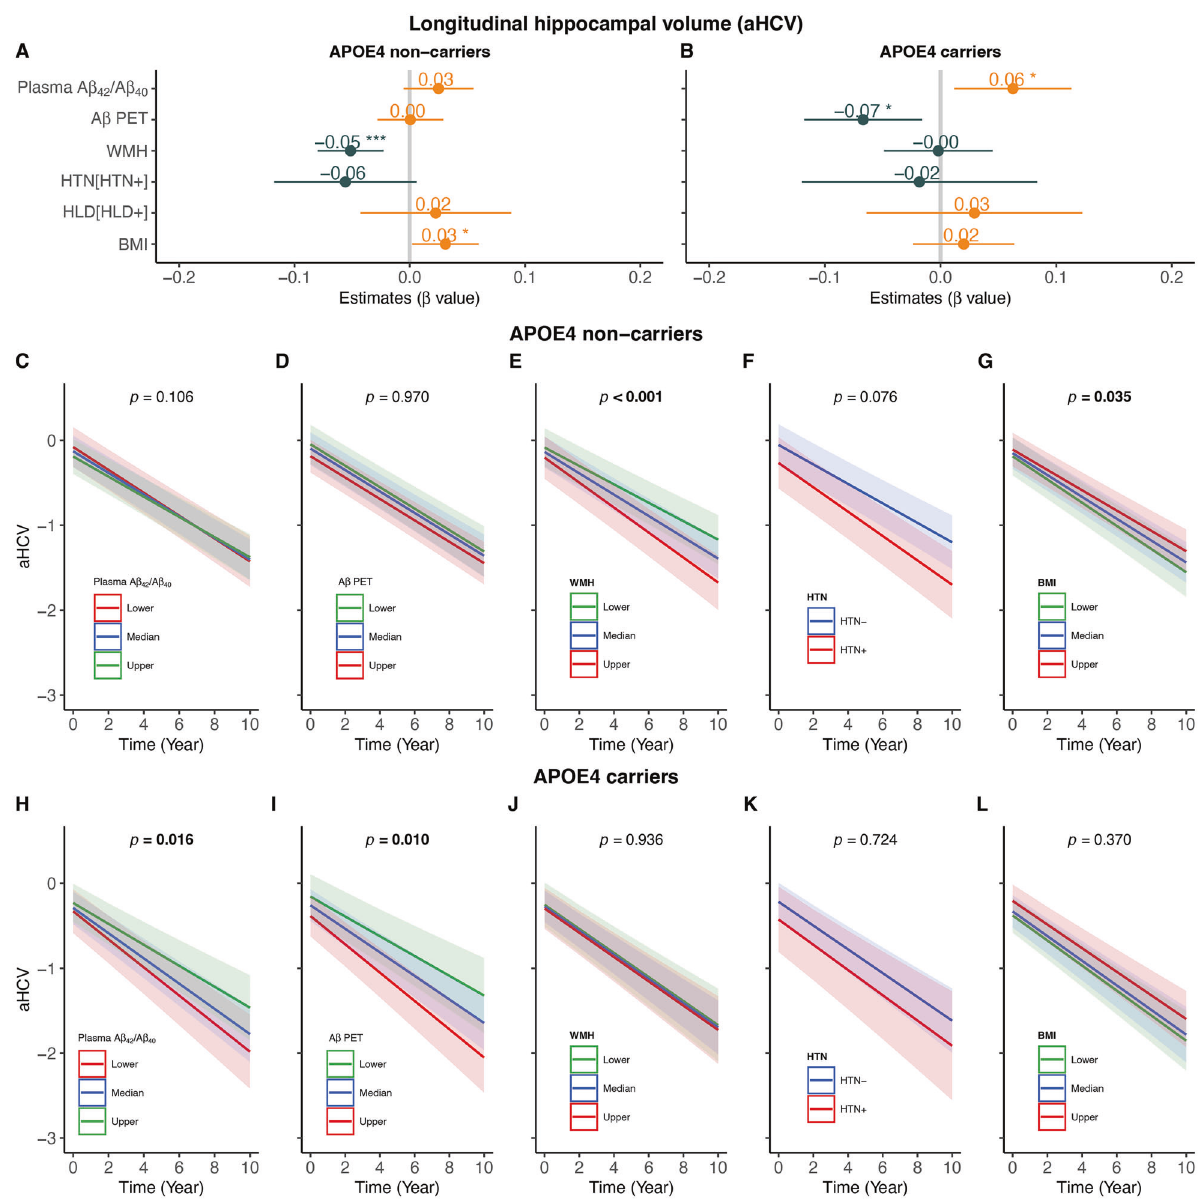
Fig. 3 Predictors of longitudinal hippocampal atrophy. Associations of longitudinal adjusted hippocampal volume (aHCV) with baseline plasma A β 42 /A β 40 , A β PET, WMH, hypertension (HTN), hyperlipidemia (HLD) and body mass index (BMI) in ( A ) APOE- ε 4 non-carriers and ( B ) APOE- ε 4 non-carriers. Prediction of longitudinal aHCV changes over time by baseline plasma A β 42 /A β 40 , A β PET, WMH, HTN and BMI in APOE- ε 4 non-carriers ( C – G ) and APOE- ε 4 carriers ( H – L ). Notes: APOE- ε 4 non-carriers (HTN − : n = 60, HTN + : n = 43), APOE- ε 4 carriers (HTN − : n = 44, HTN + : n = 18); lower, median and upper represent the value that cuts off the fi rst 25%, 50% and 75% of the data when it is sorted in ascending